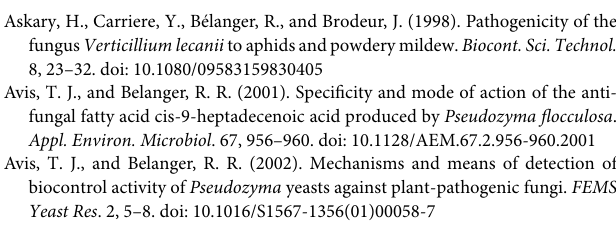
Percentage of spore inhibition after 24h on cucumber cotyledon disks covered with P. aphidis crude extract (PA) or EtOAc (Control). Data represent the means ±